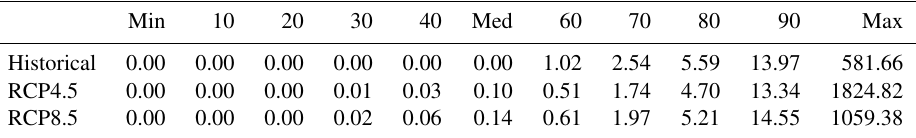
Table B2. ESM2G daily total precipitation (mm) quantiles for the observed historical GHCN climate, the downscaled RCP4.5 climate, and the downscaled RCP8.5 climate.